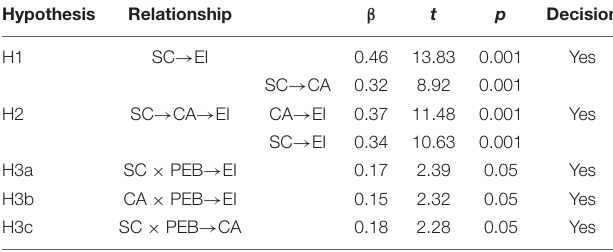
TABLE 4 | Results of hypothesis